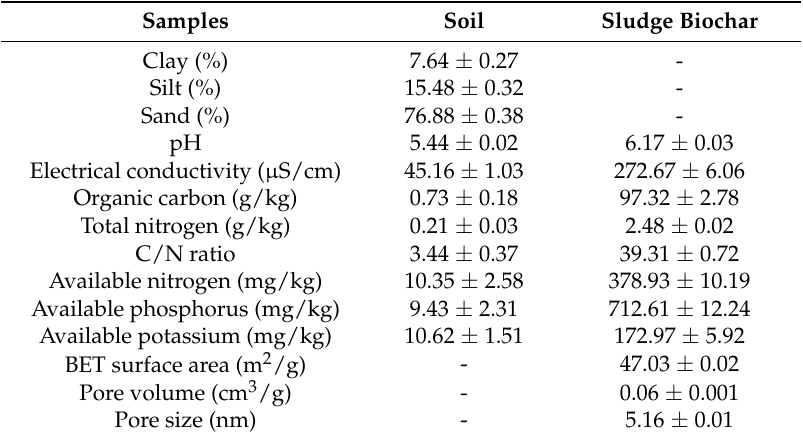
Table 1. Properties of soil and sludge biochar used in